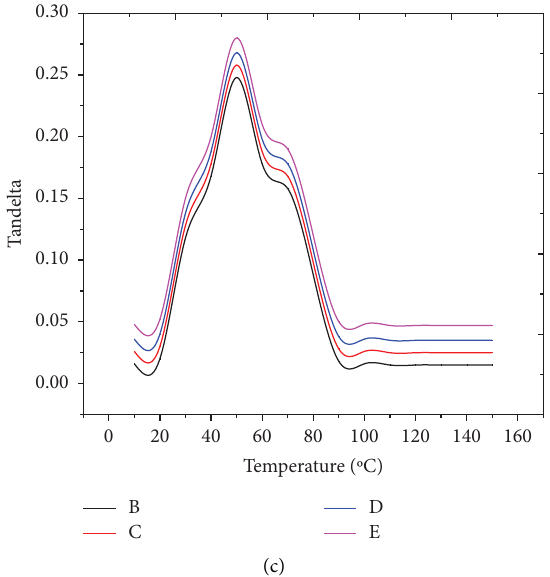
Figure 6: Temperature vs storage modulus, loss modulus and tan